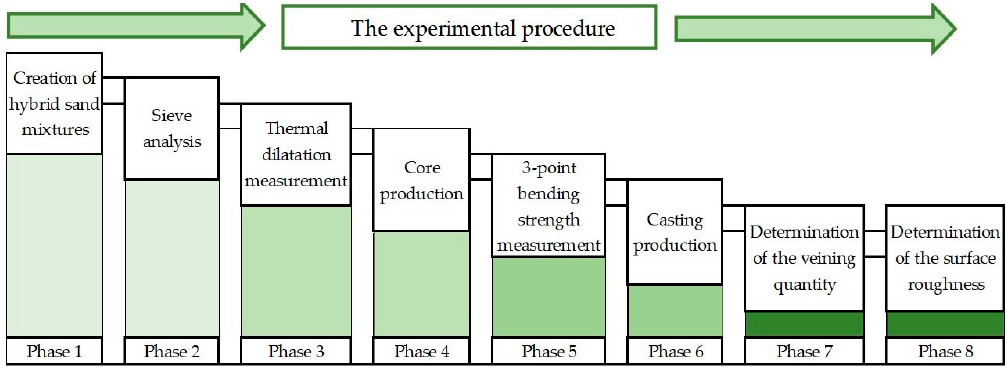
Figure 1. A schematic of measurement and sample production sequence